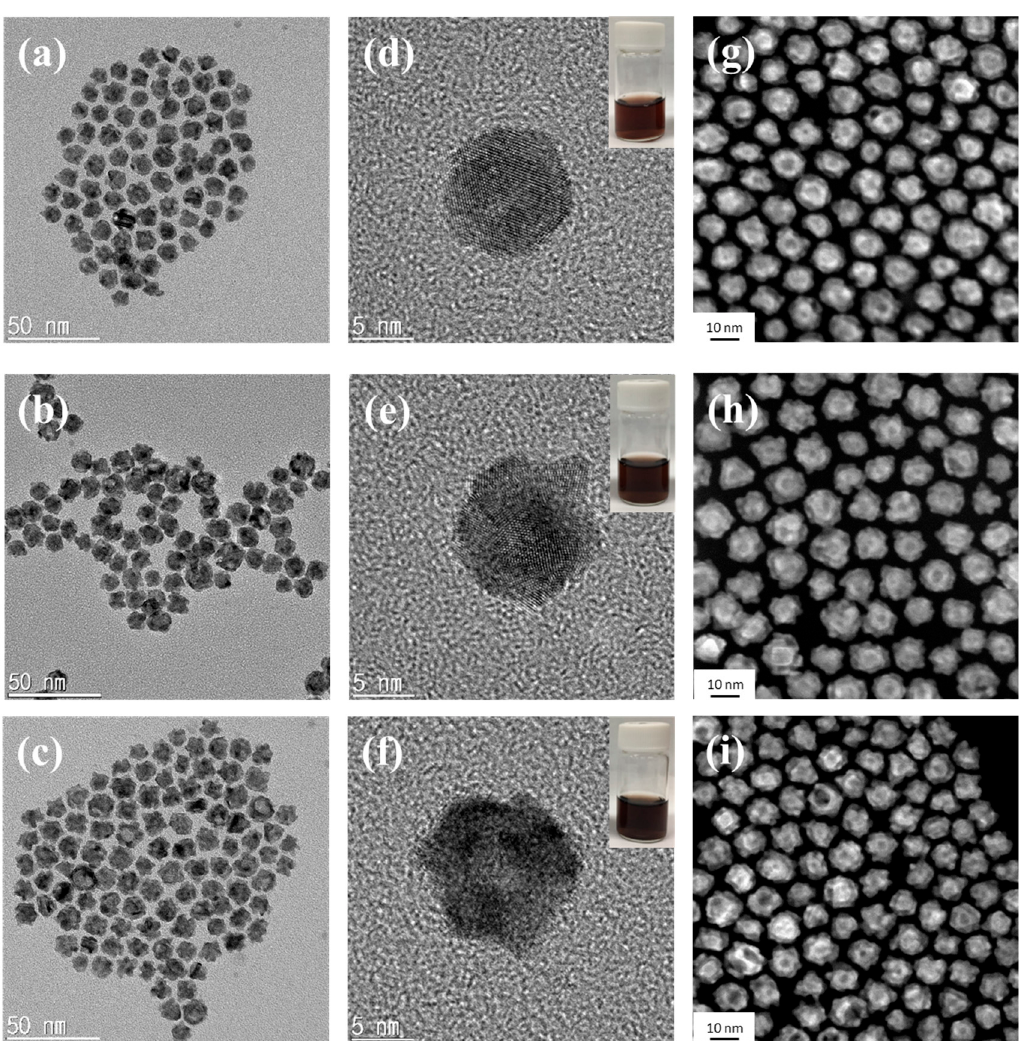
Figure 3. TEM images ( a – c ), HR-TEM images ( d – f ), and HAADF-STEM images ( g – i ) of Pt nanocluster-anchored hollow Ag-Au nanostructures with an injected molar ratio of Pt / Au from 1 to 3. The inset pictures in HR-TEM images are digital photographs of resultant solution of the obtained nanostructures.